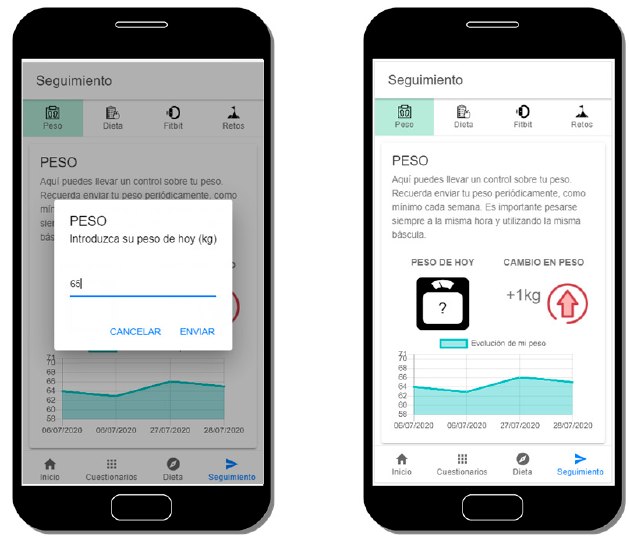
Figure 8. Input to insert users’ weight (left) and evolution weight (right).